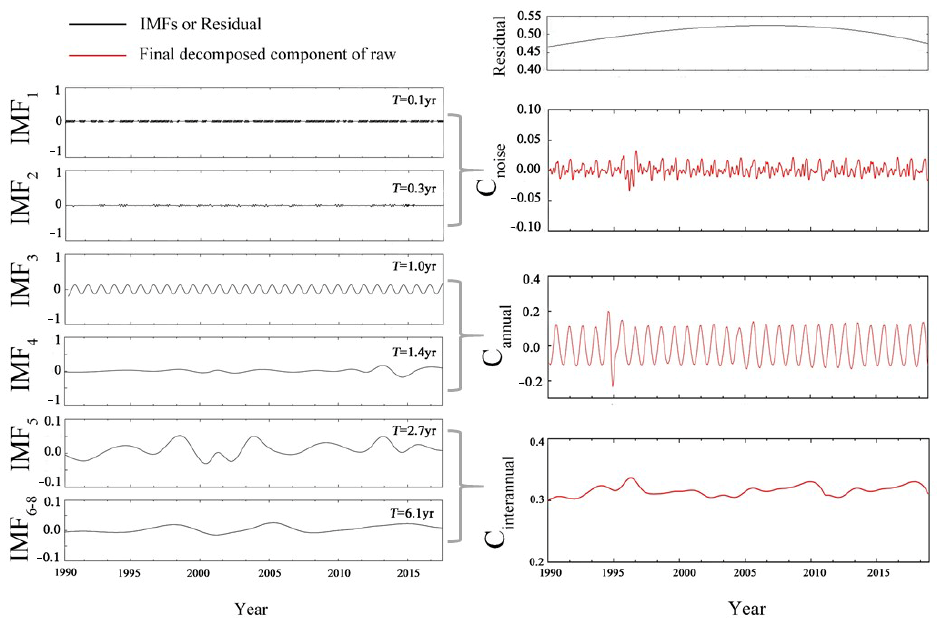
Figure 4. The architecture of EEMD for reconstructing NDVI time series.